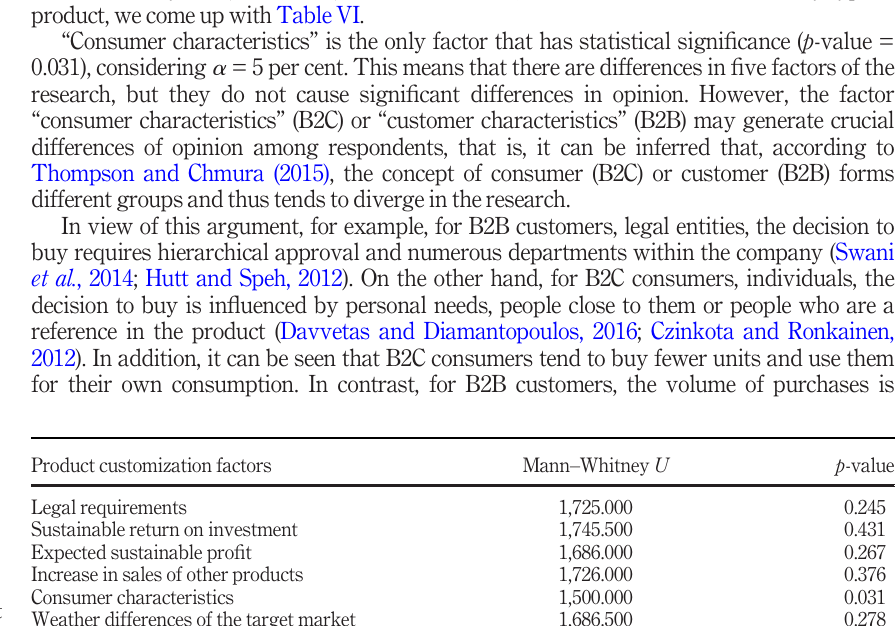
for the variable